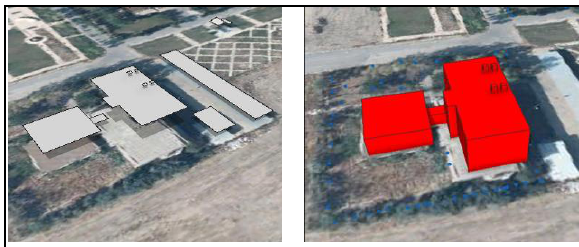
Figure 5. Imported building to CityEngine: (left) digitised building showing real elevation, (right) generated solid shape